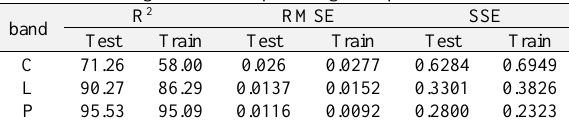
Table 6. Results of SVR model with optimal features selection with SFS algorithm with optimizing SVR parameters